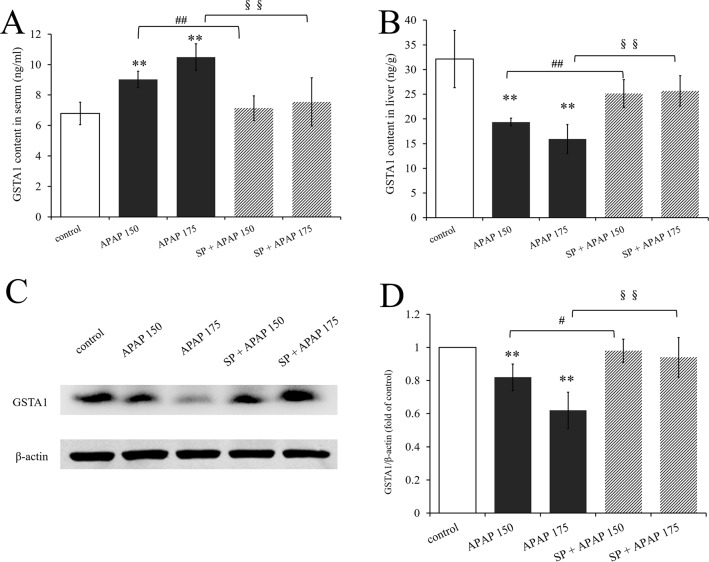
Changes of GSTA1 caused by different dosages of APAP in mice with or without SP600125. (A) Change of GSTA1 content under different dosages of APAP in serum of mice with or without SP600125, n = 6. (B) Change of GSTA1 content under different dosages of APAP in liver of mice with or without SP600125, n = 6. (C) Western blot analyses of total tissue lysate for GSTA1 and β-actin (loading control), n = 3. (D) Change of GSTA1 expression (fold of GSTA1/β-actin) under different dosages of APAP in liver of mice with or without SP600125, n = 3. Values represented as means ± SD. *Represents statistical differences caused by APAP. #Represents statistical differences caused by SP600125 under 150 mg·kg−1 APAP. §Represents statistical differences caused by SP600125 under 175 mg·kg−1 APAP. 0.05 > P > 0.01 (#). P < 0.01 (**, ##, §§).